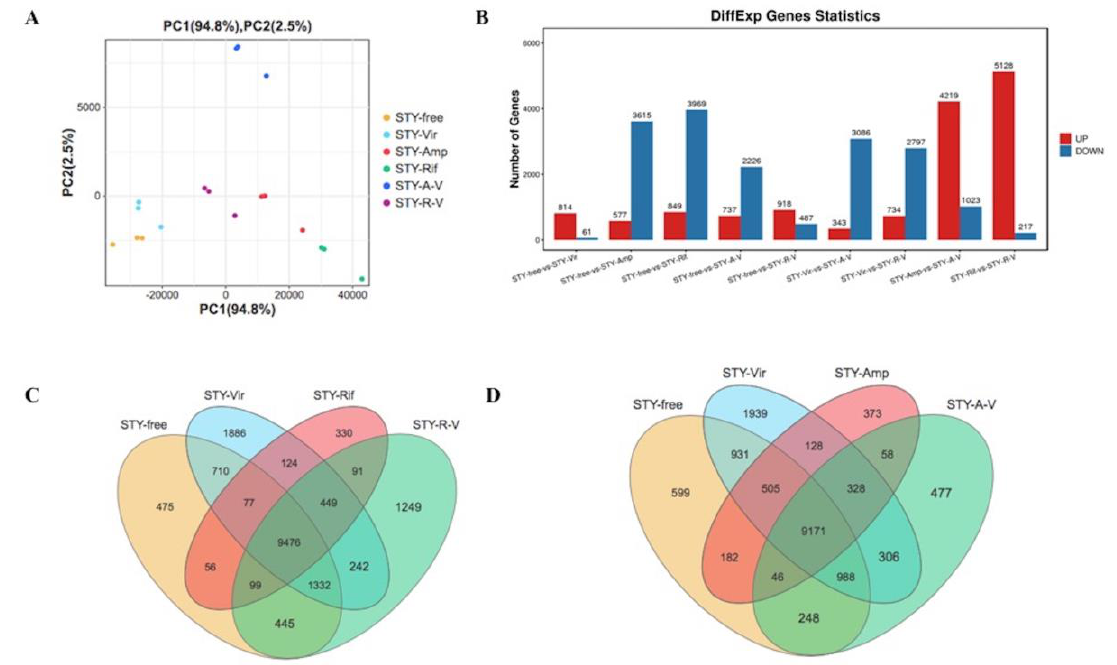
Figure 2. Transcriptomic overview of Sitobion miscanthi feeding on antibiotics and BYDV − PAV. ( A ) PCA plot of global transcriptome profiles. ( B ) Total number of transcripts that were significantly up − or down − regulated in response to aphids feeding on antibiotics and BYDV − PAV. ( C ) Venn diagram illustrating the number of genes up − or down − regulated by aphids feeding on rifampicin over the time course. p < 0.01 FDR and Log2 FC ≥ 1 or ≤− 1. ( D ) Venn diagram illustrating the number of genes up − or down − regulated by aphids feeding on ampicillin over the time course. p < 0.01 FDR and Log2 FC ≥ 1 or ≤−